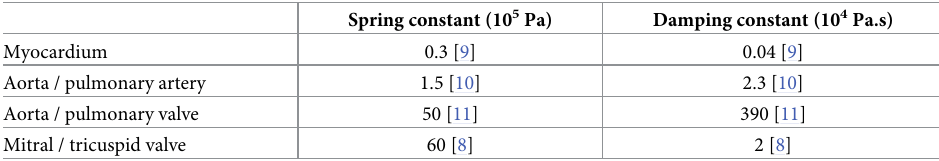
Table 1. Mechanical properties of